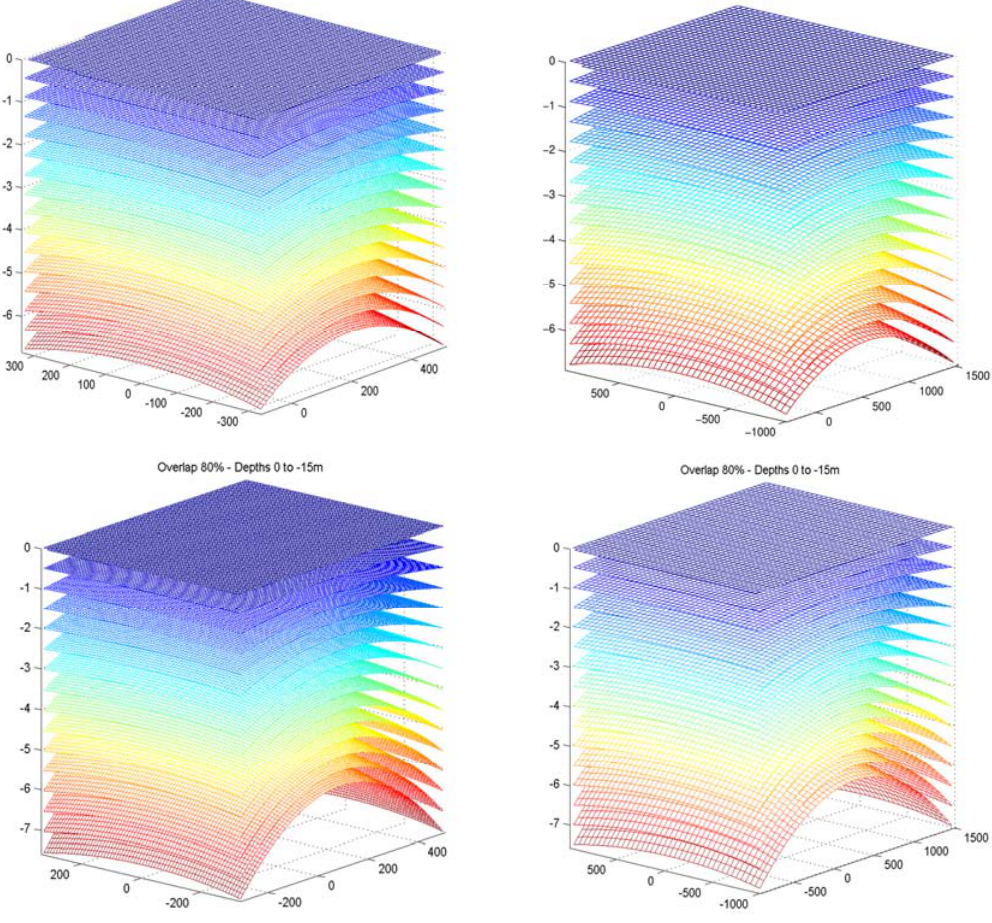
Figure 6. Difference of apparent and correct depth, for depths 0–15 m, if acquired with an Vexcel UltraCamX with 100.5 mm lense, with 60% overlap ( top row ), 80% overlap ( bottom row ), from 1000 m height ( left column ), and 3000 m, ( right column ).